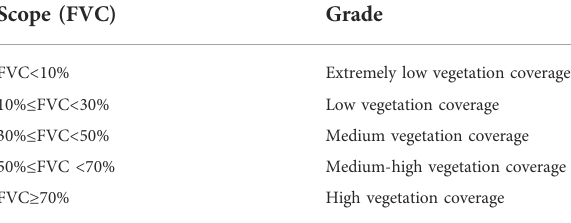
TABLE 1 Classi fi cation of vegetation coverage grade in the study area.